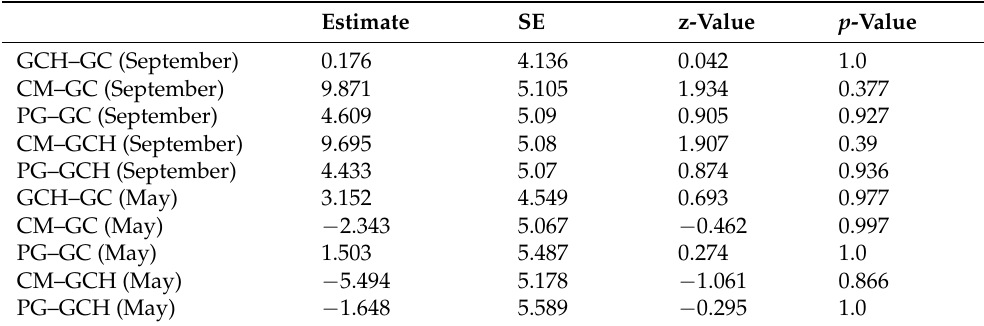
Table A17. Differences in activity densities of carnivore carabid beetles, comparing grass–clover (GC) and grass–clover herbs (GCH) with each other, and in comparison to conventional maize (CM) and permanent grasslands (PG) in May/June and September.